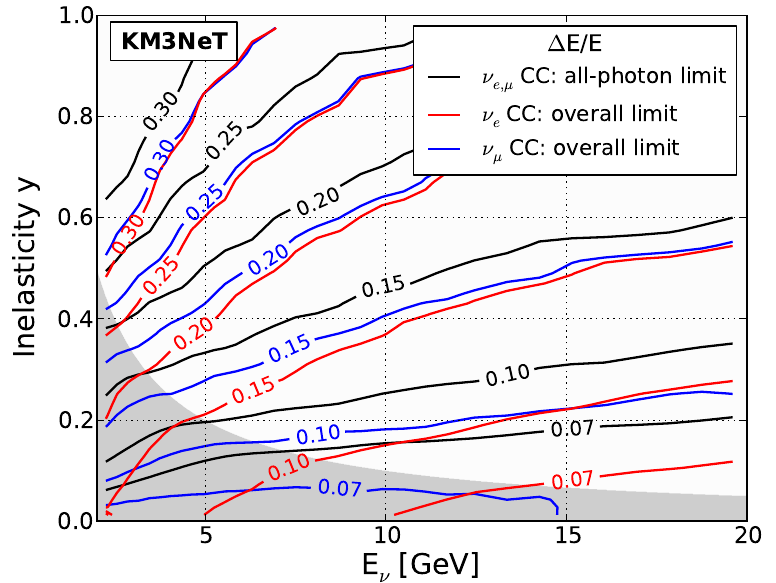
Figure 11 . Limitations on relative neutrino energy resolution (RMS) as a function of neutrino energy E (cid:23) and inelasticity y . Resolutions are shown as contour lines for , - (cid:23) e;(cid:22) CC in the all-photon limit (black), for , - (cid:23) e CC in the overall limit (red), and for , - (cid:23) (cid:22) CC in the overall limit (blue). The region E h < 1 GeV (grey shading) has been calculated using extrapolated hadronic cascade results, and should be interpreted with